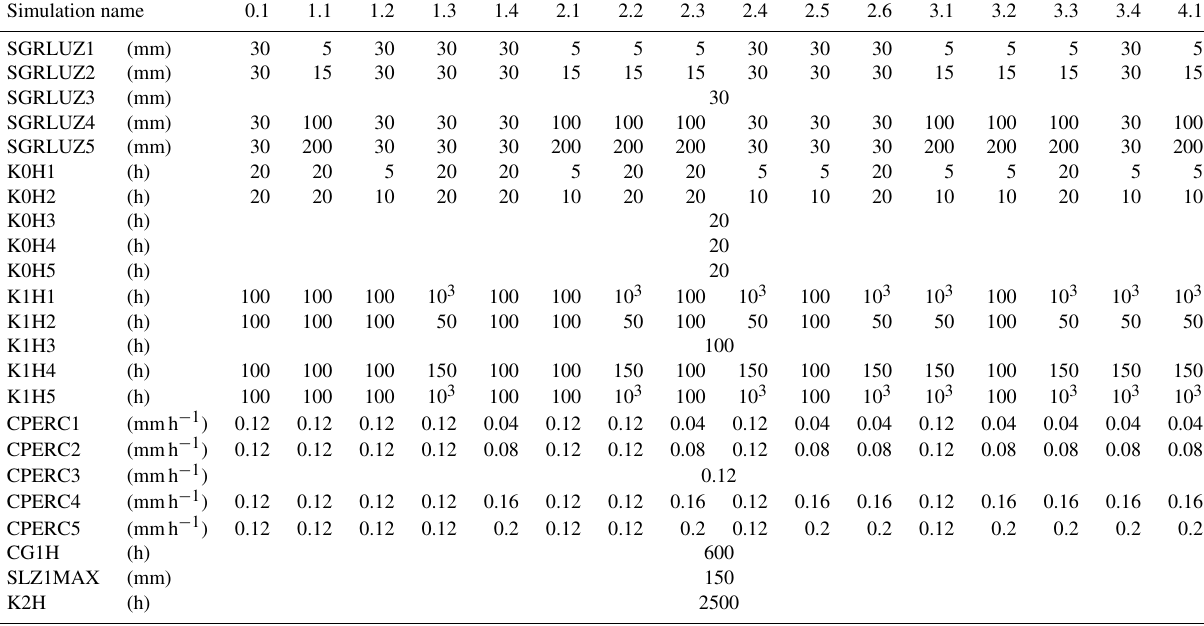
Table A2. Parameter values used for the 16 runs of the synthetic runoff simulations. The simulation names are of the form “ i . j ”, where i refers to the number of parameters defined based on the RTs and j refers to the different